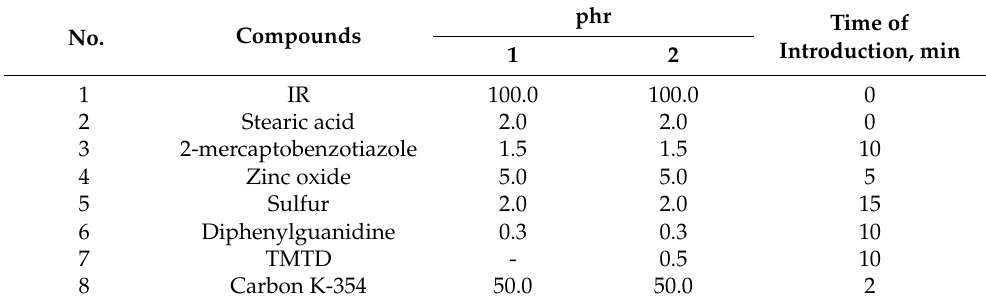
Table 1. Isoprene Rubber Standard Blend Formulation (Formulation: Bulk Parts per 100 Rubber Parts). No. Compounds